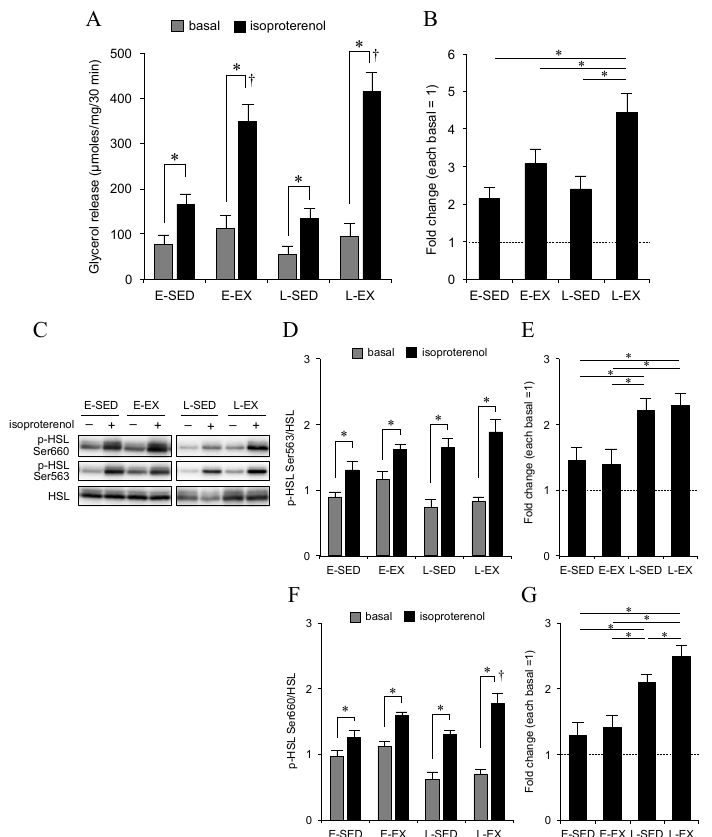
Figure 4. Effect of exercise training timing on lipolysis in basal conditions and after stimulation by isoproterenol in primary adipocytes isolated from epididymal adipose tissues. ( A ) Levels of basal and isoproterenol-induced glycerol release, as an index of lipolysis, from adipocytes isolated from the four groups: E-SED, L-SED, E-EX, and L-EX rats ( n = 6 per group). ( B ) Isoproterenol-stimulated lipolysis expressed as fold induction over basal lipolysis in the groups (levels in respective sedentary controls were set to 1). ( C ) Representative expression of HSL phosphorylated at Ser563 and Ser660 as measured by Western blotting. ( D ) Relative expression levels of HSL phosphorylated at Ser563 to the total HSL level, and ( E ) its expression over respective basal conditions. ( F ) Relative expression levels of HSL phosphorylated at Ser660 to total HSL level, and ( G ) its expression over respective basal conditions. The values of the bar graphs in panels B, E, and G are shown relative to the mean level detected in basal conditions, which was arbitrarily set to 1. In all experiments, values represent the means ± S.E. from 6 rats in each group. * p < 0.05, or less. † p < 0.05 or less, E-SED vs. E-EX or L-SED vs. L-EX. The abbreviations for the groups of rats are shown in Figures 2 and